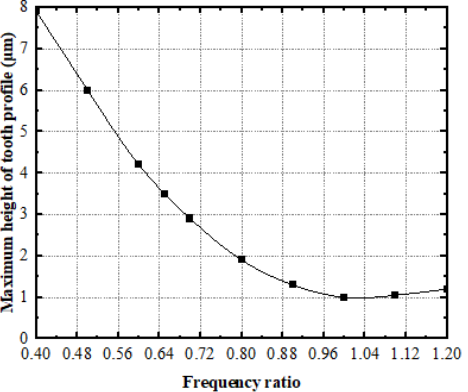
Figure 8. The effect of frequency ratio on the maximum height of face gear.